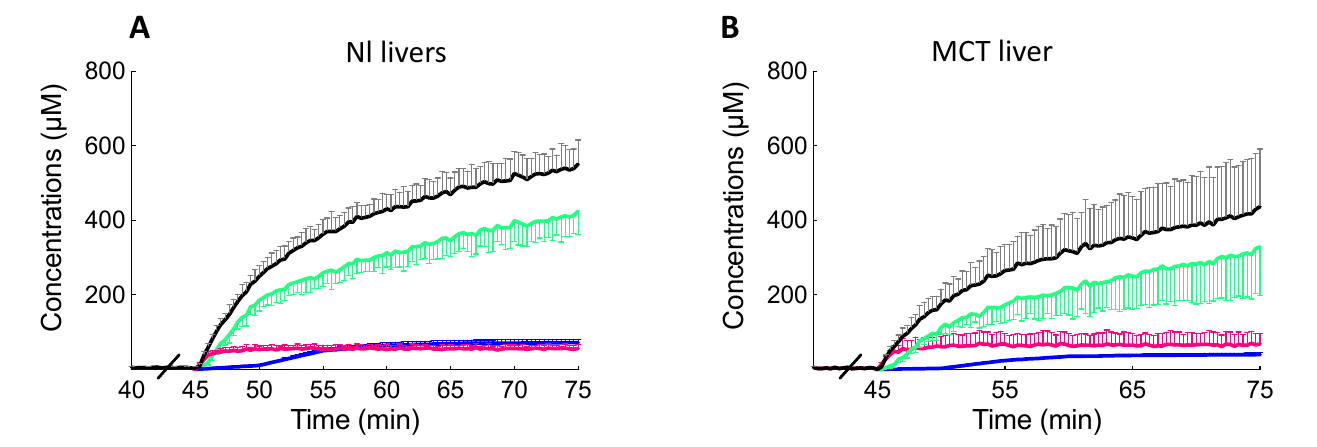
Figure 3. BOPTA compartmental distribution in normal (Nl, A ) and MCT livers ( B ). Livers were perfused with Krebs–Henseleit bicarbonate solution (KHB) + 200 µM [ 153 Gd]BOPTA (45 to 75 min). Liver concentrations (black symbols) were measured by a gamma counter. Concentrations in extracellular compartment (red symbols) were measured during DTPA perfusion. Concentrations that originate from bile canaliculi (blue symbols) and from 78% hepatocytes (green symbols) were calculated. Table 1. BOPTA values at the end of the accumulation period at time 75 min.